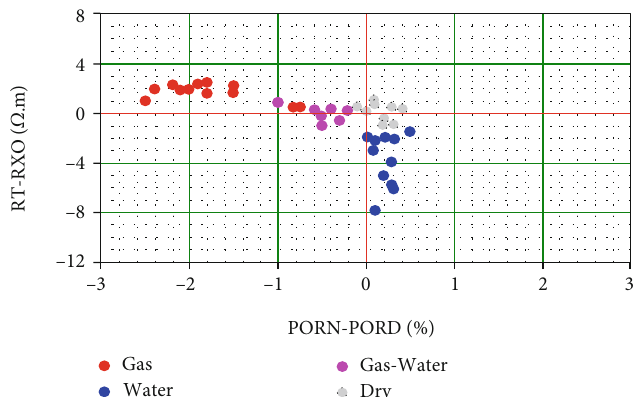
Figure 5: Intersection diagram of reservoir resistivity and di ff erence between neutron porosity and density porosity in P